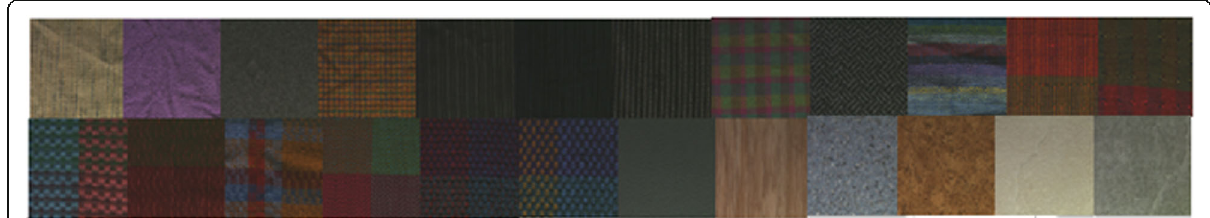
Fig. 8 Twenty-four texture classes of images from Outex